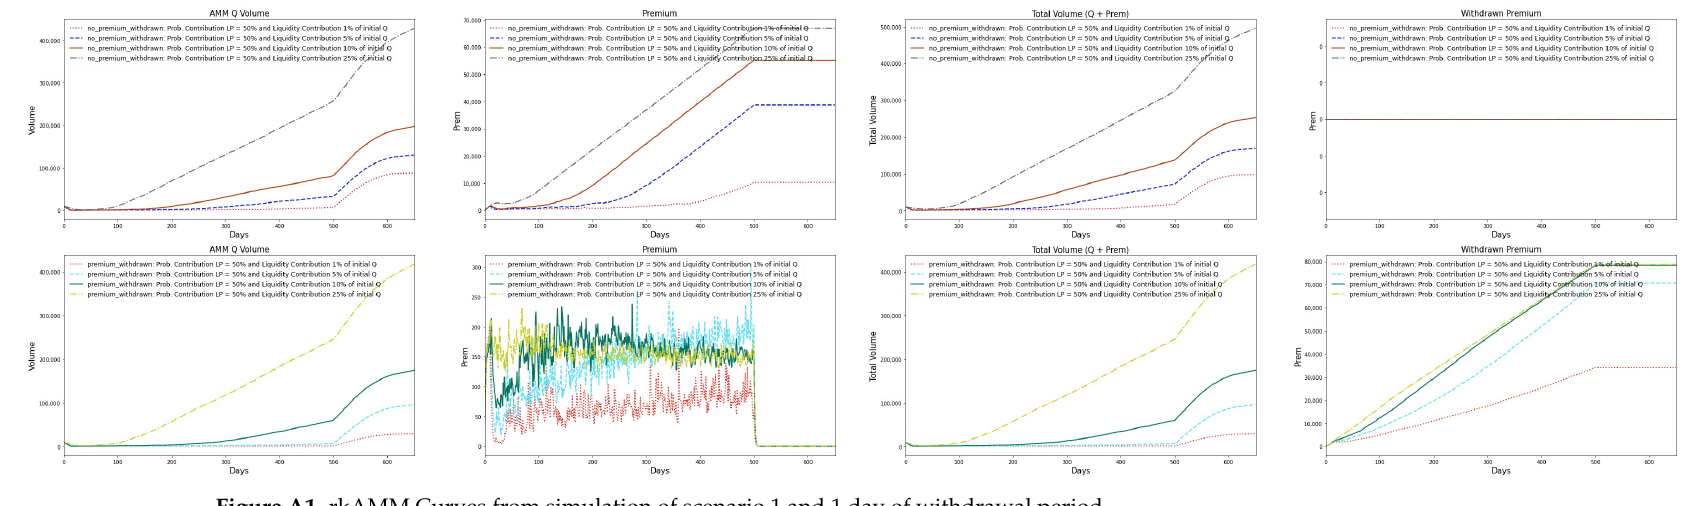
Figure A1. rkAMM Curves from simulation of scenario 1 and 1 day of withdrawal period.